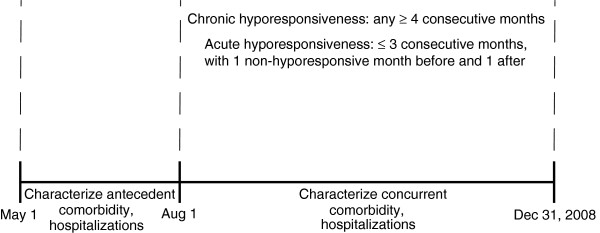
Study time periods. The months August through December were used to characterize hyporesponsiveness and comorbidity concurrent with the hyporesponsiveness period. The months May through July were used to characterize comorbidity prior to the hyporesponsive period (antecedent period).